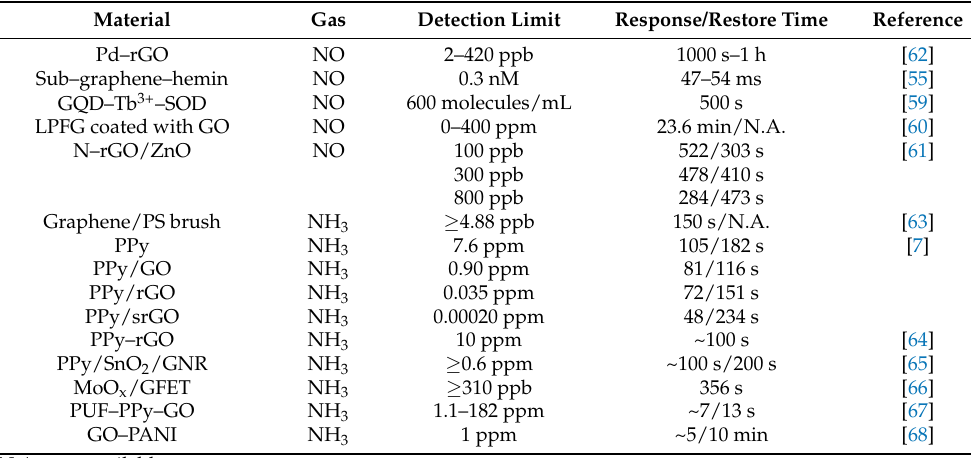
Figure 5. ( a ) The structure of GO–LPFG and the response mechanism to NO [60]. Copyright (2019), used with permission from Elsevier. ( b ) Physical model of NGZ–0.3 (the volume of NH 4 OH is 0.3 mL) composite material N–rGO/ZnO (NGZ); ( c ) physical model of NGZ–0.1 or NGZ–0.5 (NH4OH volume 0.1 and 0.5 mL) composite material [61]. Copyright (2020), used with permission from Elsevier. Table 2. The detection range and response time of other graphene composite materials to NO, NH3 gas.